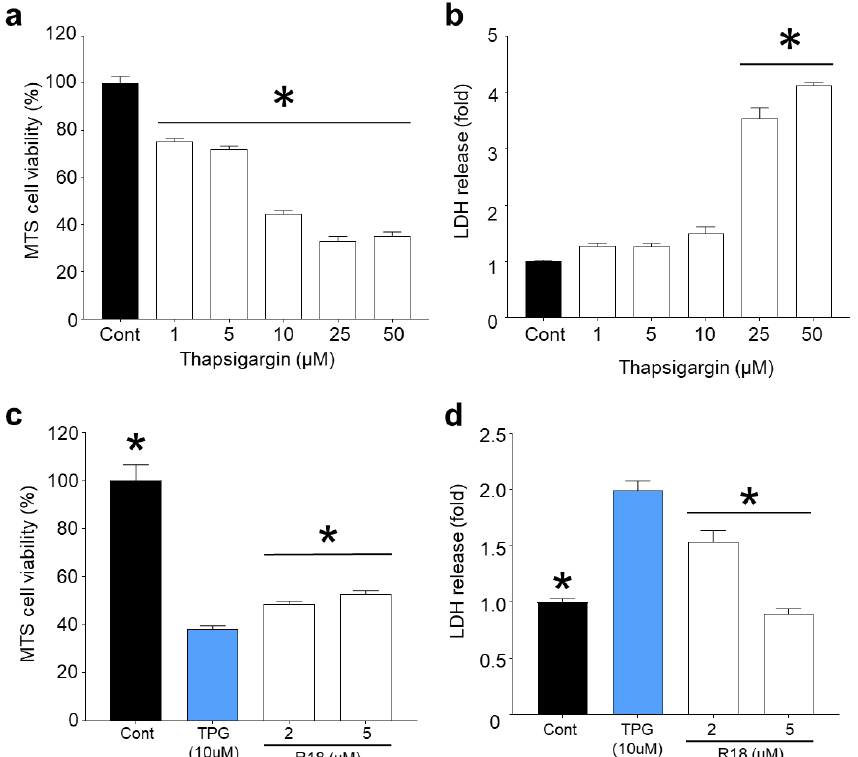
Figure 5. R18 protects primary cortical neurons against thapsigargin-induced neuronal death and ER- mediated calcium release. A 24 h exposure of primary cortical neuronal cultures to thapsigargin (TPG) causes ( a ) a significant reduction in MTS metabolism and ( b ) increased LDH release in a dose-